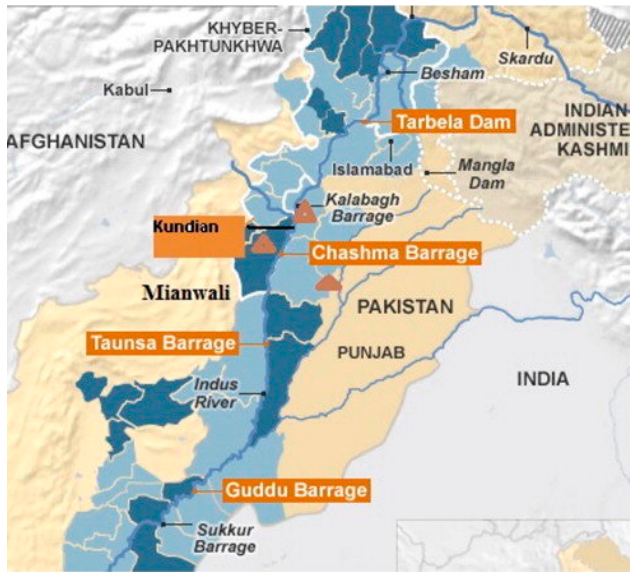
Figure 1. Location map of Tarbela dam.